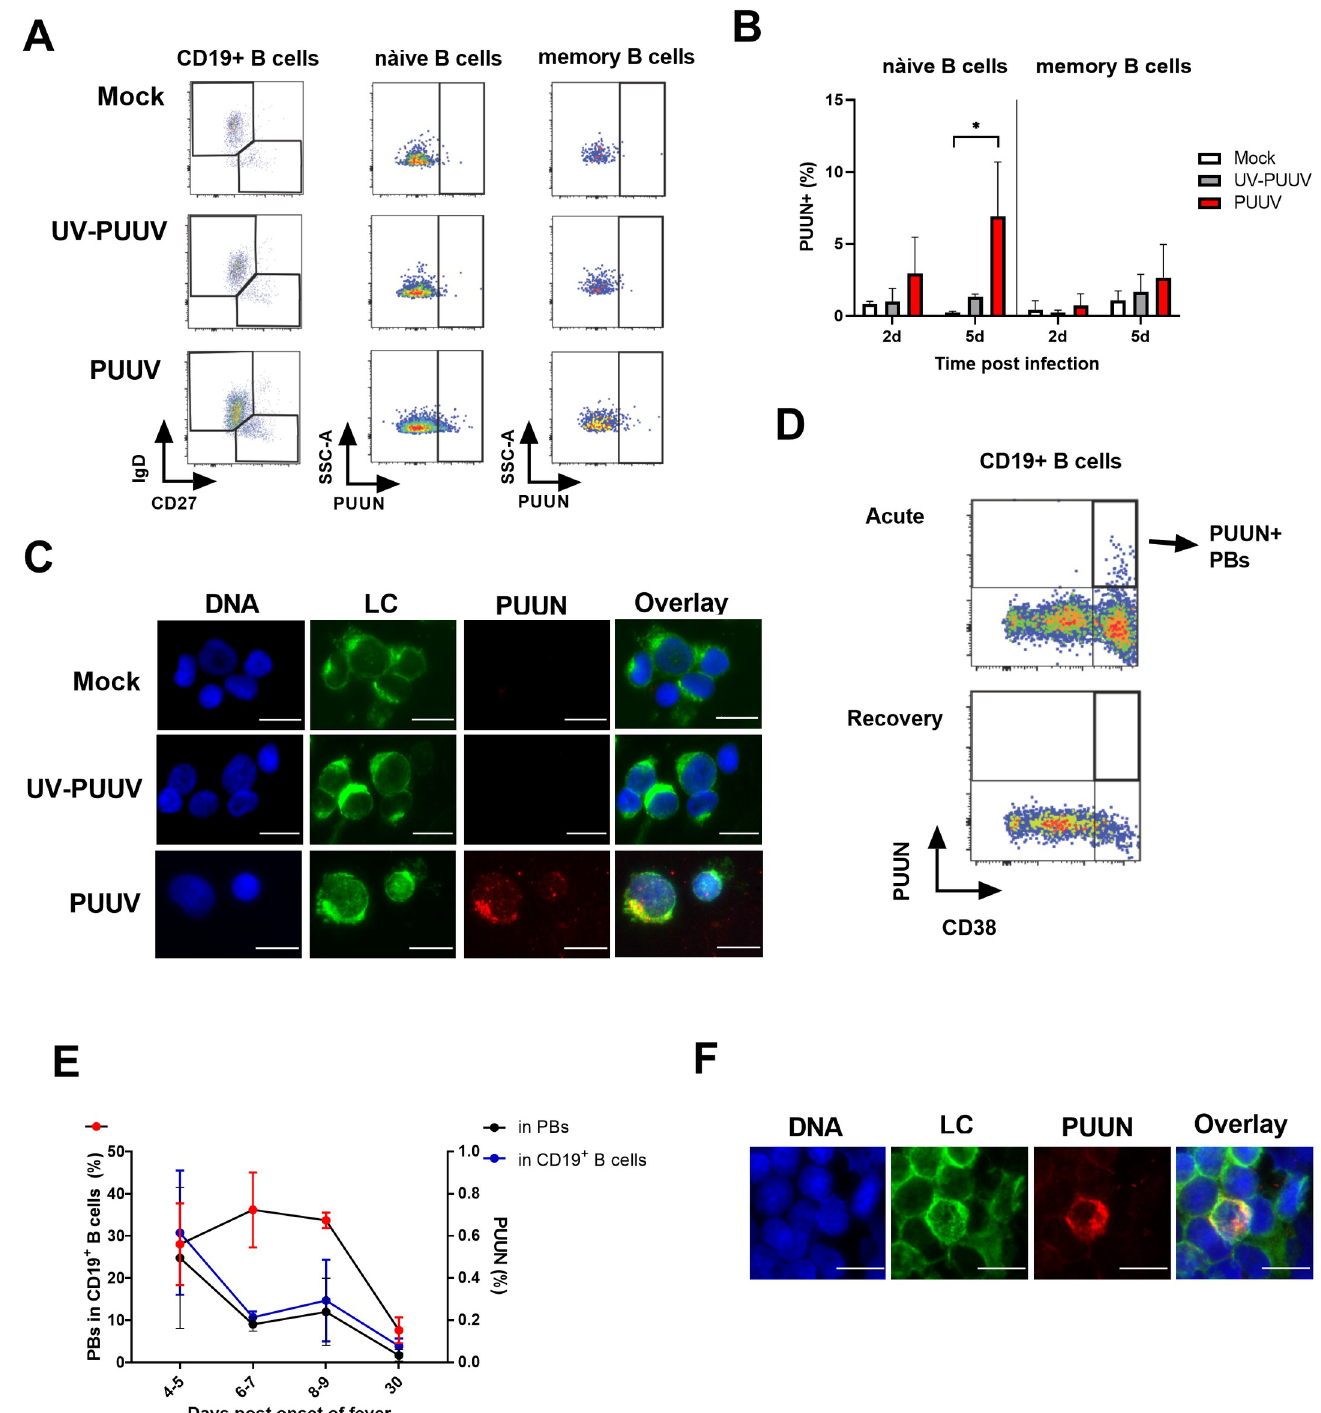
Fig 6. PUUV infects B cells. ( A , B ) PBMCs from healthy volunteers were inoculated with live PUUV or UV-inactivated PUUV as a control at a multiplicity of 5 FFFU virus/PBMC and cultured for 2 or 5 days. Na ï ve (CD19 + IgD + CD27 - ) and memory (CD19 + IgD - CD27 + ) B cells were identified by multi-parametric flow cytometry and, as an indication of PUUV infection, intracellular staining for PUUN using PUUN-specific AlexaFluor647-conjugated Mab 1C12 was included. ( A ) An example of the gating strategy to detect PUUN + na ï ve or memory B cells is shown. ( B ) The mean frequencies of PUUN + cells out of total number of na ï ve or memory B cells in inoculated PBMCs were compared between non-treated and PUUV or UV- PUUV inoculated groups with two-way ANOVA and Dunnett’s multiple comparison tests. � p < 0.05, �� p < 0.01, ��� p < 0.001. ( C ) B cells were isolated from healthy volunteer PBMCs, inoculated with live PUUV or UV-PUUV